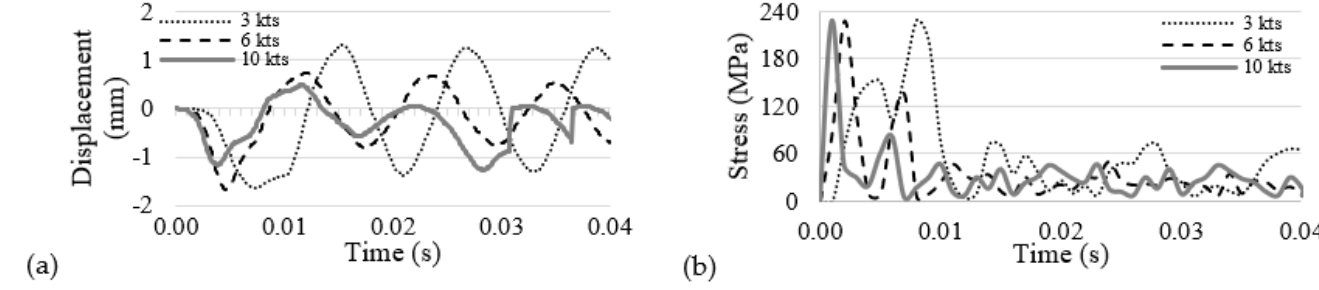
Figure 14. ( a ) Deformation, ( b ) stresses on the aluminium panel after impact with ice at speeds: 3, 6 and 10 knots.